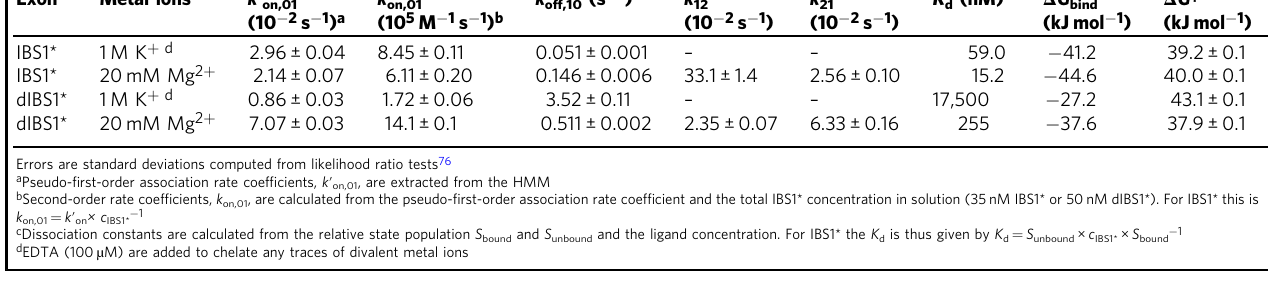
Table 1 Kinetic parameters determined with a hidden Markov model on dynamic single molecules. Exon Metal